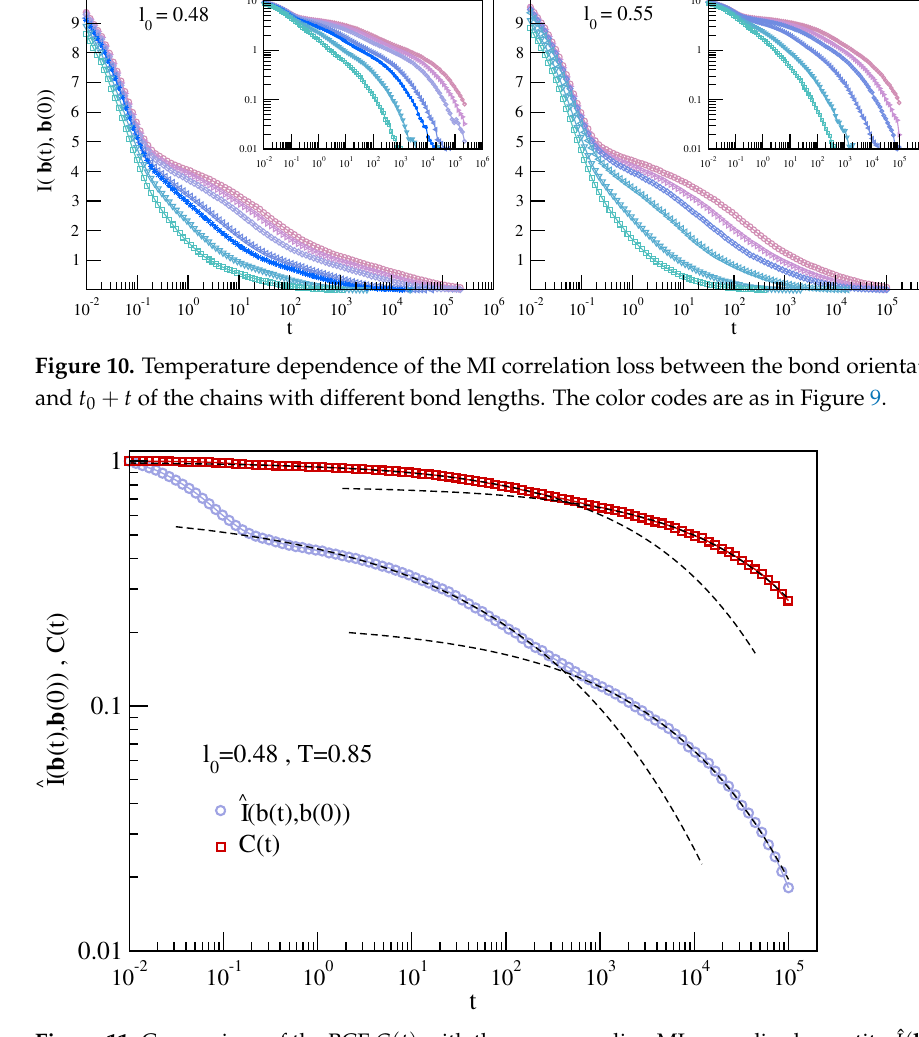
Figure 11. Comparison of the BCF C ( t ) with the corresponding MI normalised quantity ˆ I ( b ( t ) , b ( 0 )) for the state with slowest relaxation. The superimposed dashed lines are guides for the eyes. The better resolution of MI to the JG relaxation is quite